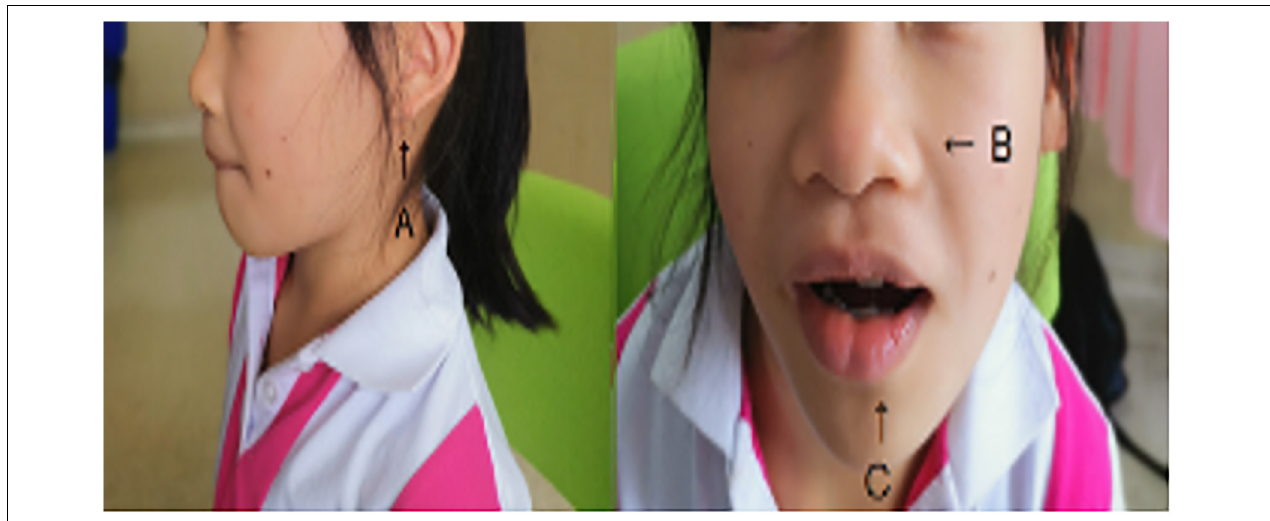
FIGURE 1 | The patient has coarse facial features, low-set and posteriorly rotated ears (A) , a flat, upturned nose (B) , sparse bitemporal scalp hair, thick eyebrows, and a wide mouth with thick lips (C) .